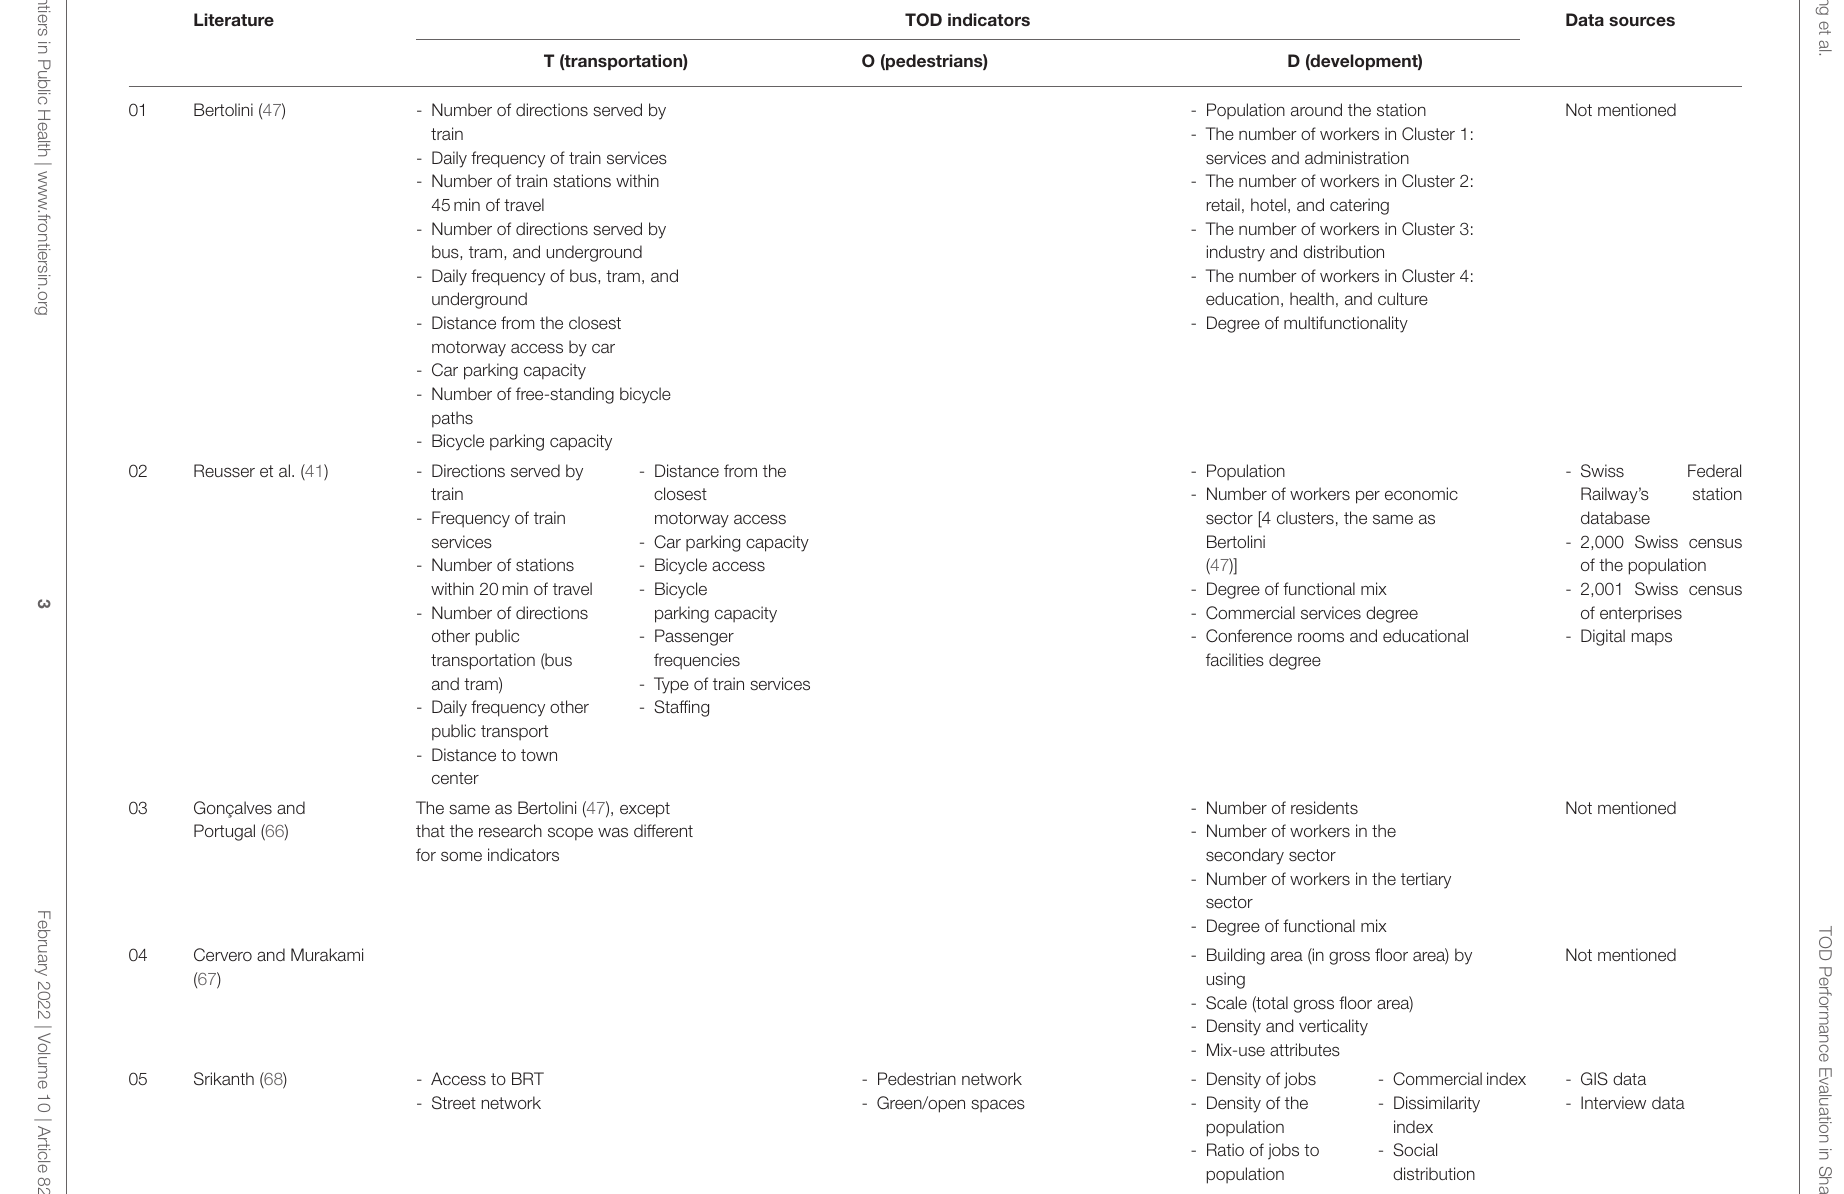
TABLE 1 | Comparison of the indicators used in the reviewed literature to measure TOD performance. Literature TOD